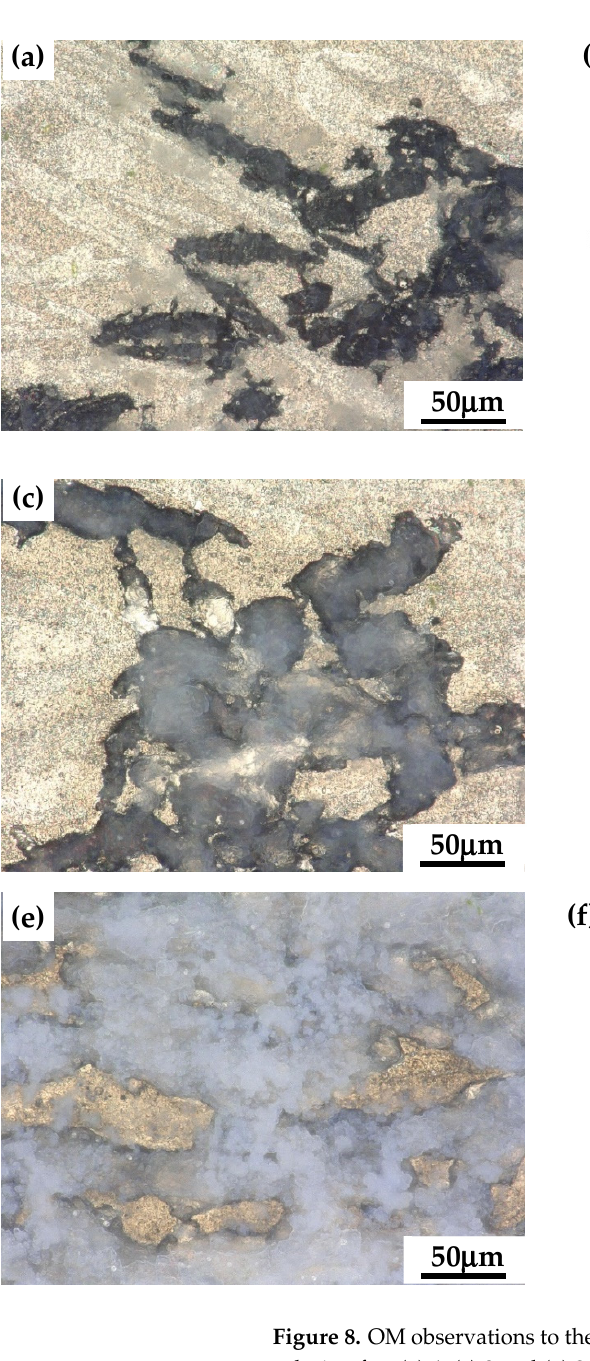
Figure 8. OM observations to the surface corrosion morphologies of the sample immersed in 3.5 wt.% solution for: ( a ) 4, ( c ) 8 and ( e ) 24 h. Images ( b ), ( d ) and ( f ) are 3D profiles of surface corrosion morphologies of samples immersed in 3.5 wt.% solution for 4, 8 and 24 h.